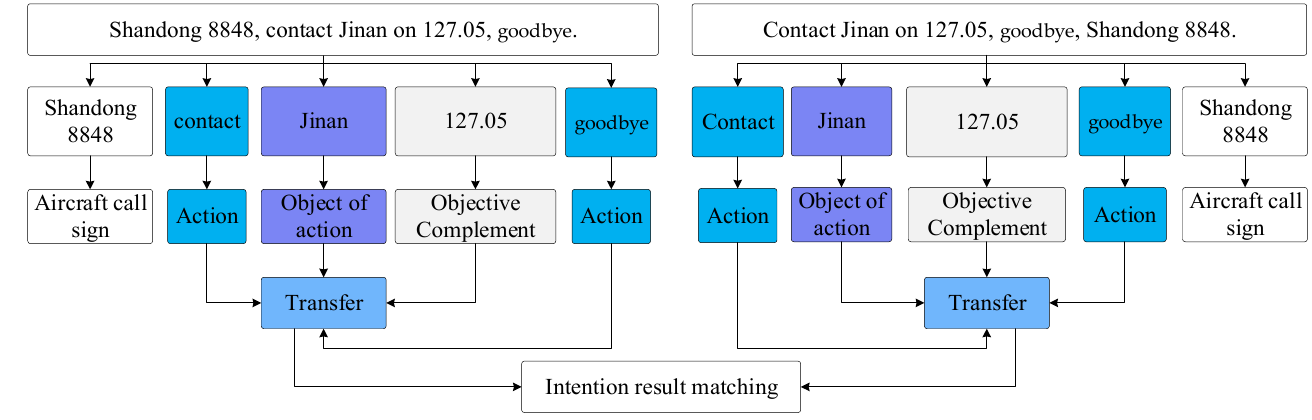
Figure 7. Instruction structure tree and intention recognition matching diagram.